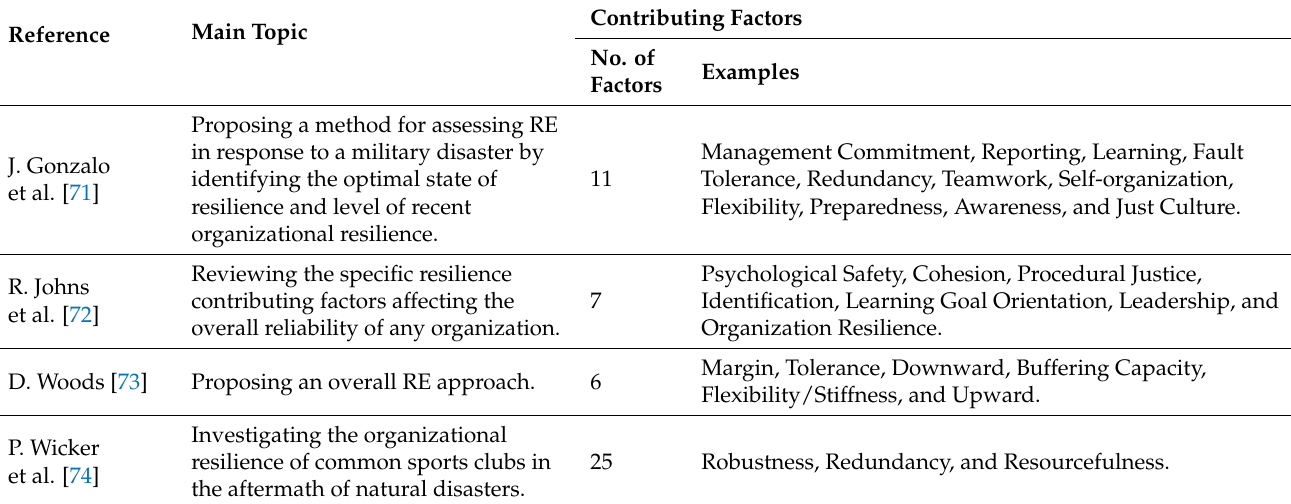
Table 7. Summary of identified contributing factors from other